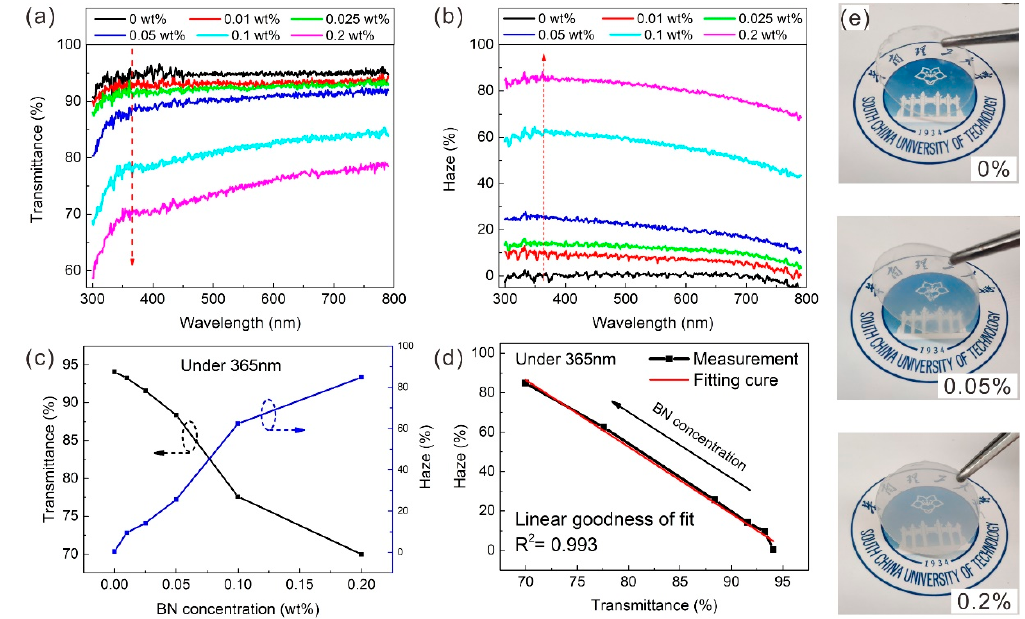
Figure 6. ( a ) The transmittance and ( b ) haze versus wavelength for different BN NP concentrations in a film. The red dotted line indicates 365 nm. ( c ) Transmittance and haze (experimental) versus BN concentration for wavelengths under 365 nm; ( d ) relationship between measured haze and transmittance; ( e ) photographs of BN films.